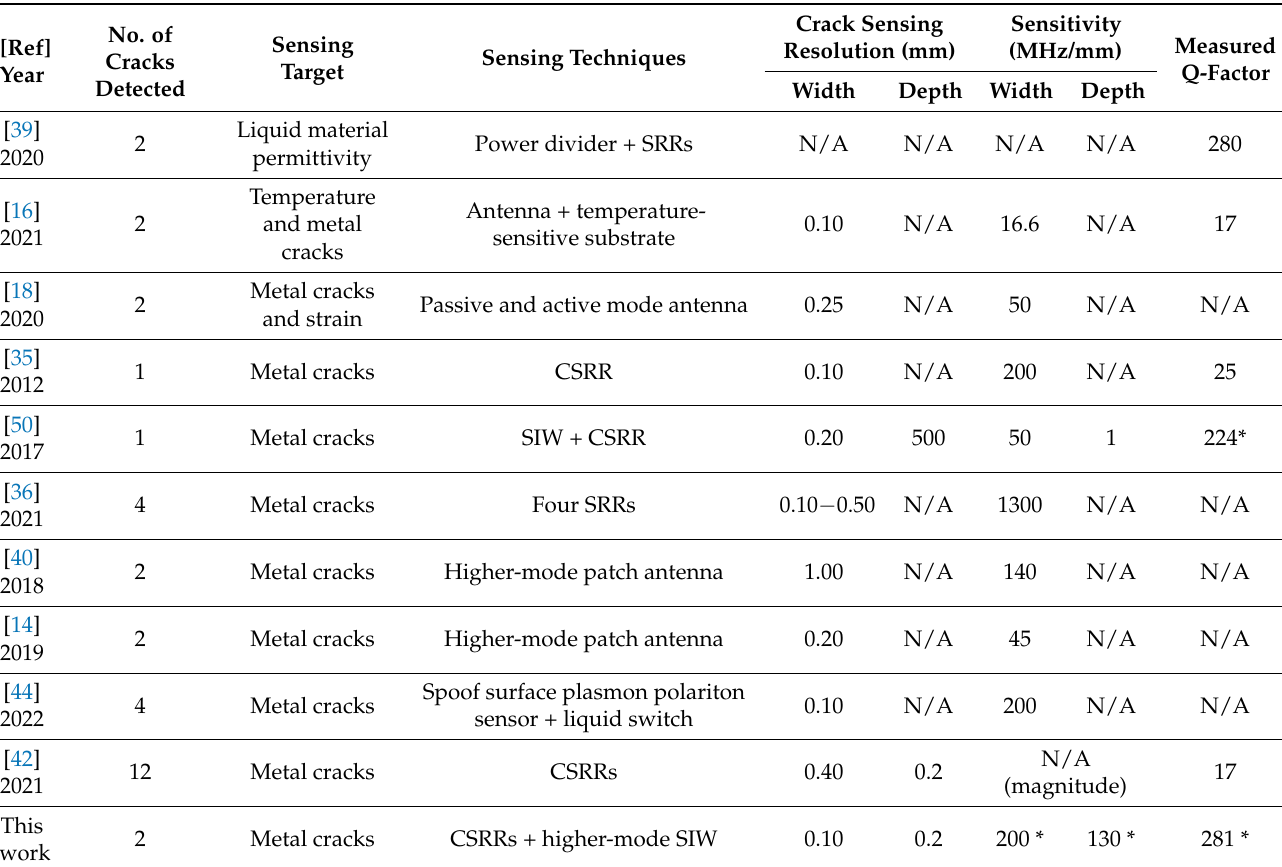
Table 1. Summary of the proposed and previously reported multi-crack detection